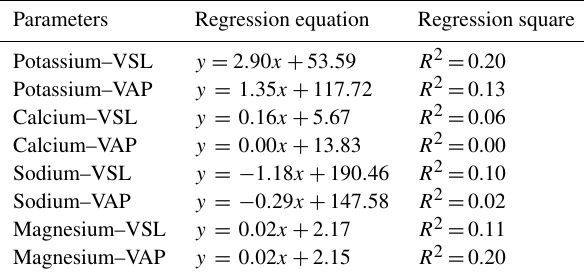
Table 3. Linear regression relationship between some ions of semen seminal plasma and the velocities of sperm cells in Capoeta trutta . Parameters Regression equation Regression